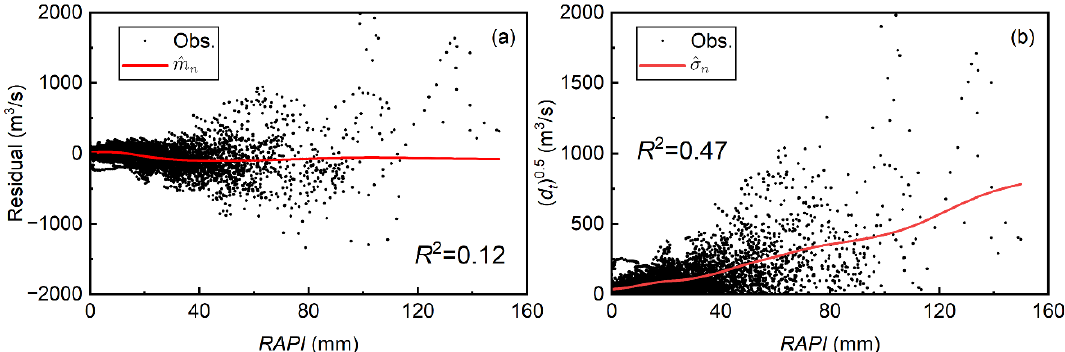
Figure 7. Illustration of the impact of the optimal RAPI on flood simulation residuals: ( a ) Optimal kernel regression function and ( b ) conditional volatility function of the residuals given RAPI as the regressor. The R-squared values are also shown.